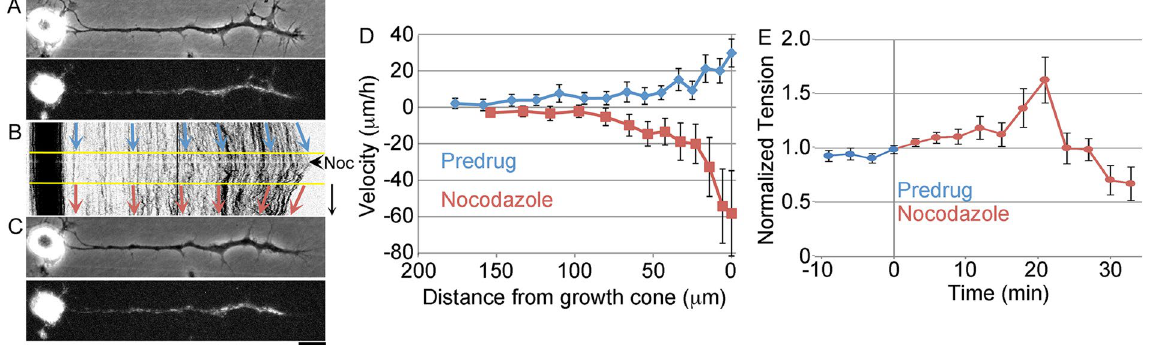
Figure 4. Disruption of MT assembly induces bulk retraction. ( A ) Still phase and fluorescent images showing the distribution of MitoTracker labeled mitochondria in a chick sensory neuron. ( B ) Kymograph illustrating the bulk forward advance of docked mitochondria before drug application, and bulk retraction following disruption of MT assembly with 1.6 μ M nocodazole; arrow = 15 min. ( C ) Still images at the end of the time- lapse sequence; bar = 20 μ m. ( D ) Velocity profile of the motion of docked mitochondria before and after drug treatment (n = 31 neurons). ( E ) Normalized neurite tension before and after drug treatment (n = 10